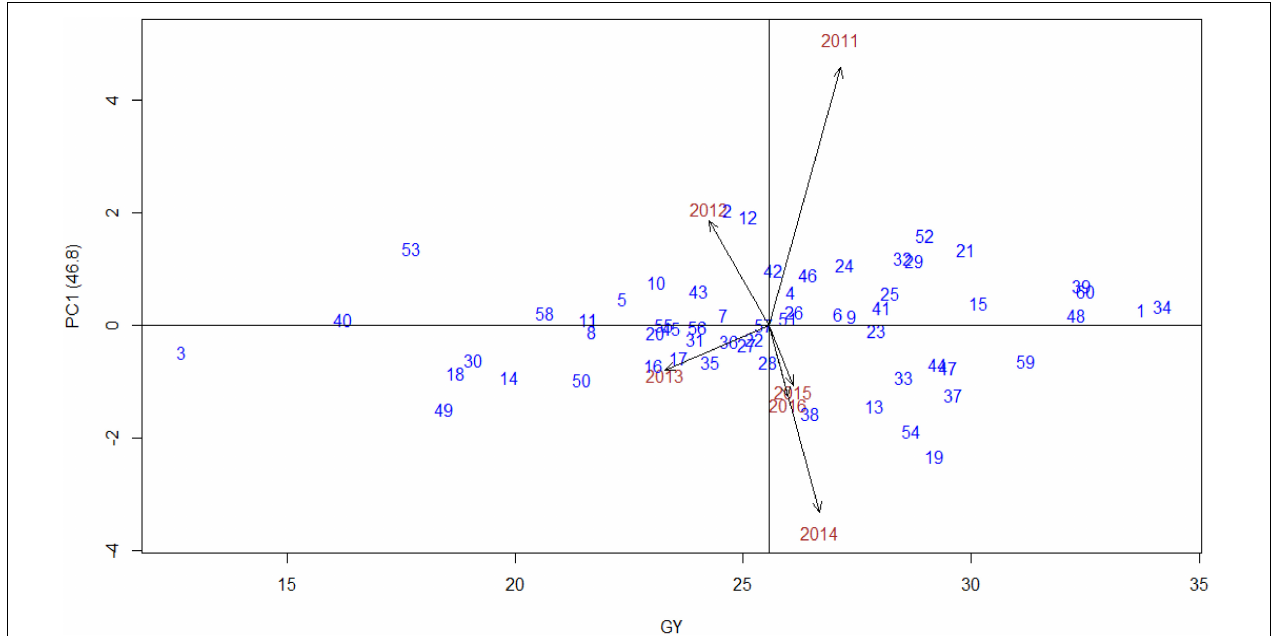
FIGURE 3 | AMMI1 biplot [grain yield vs. principal component 1 (PC1)] for grain yield (00’ kg/ha) of 60 finger millet genotypes evaluated under six test environments during the main seasons of 2011–2016.